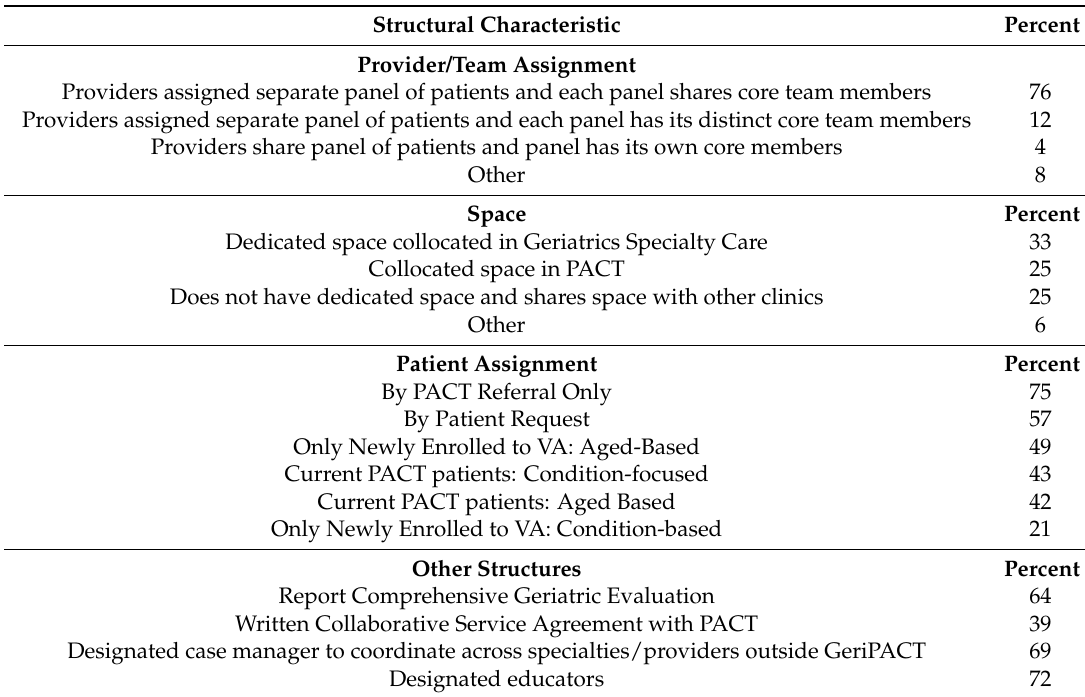
Table 3. GeriPACT Structural and Organizational Characteristics (N = 101).